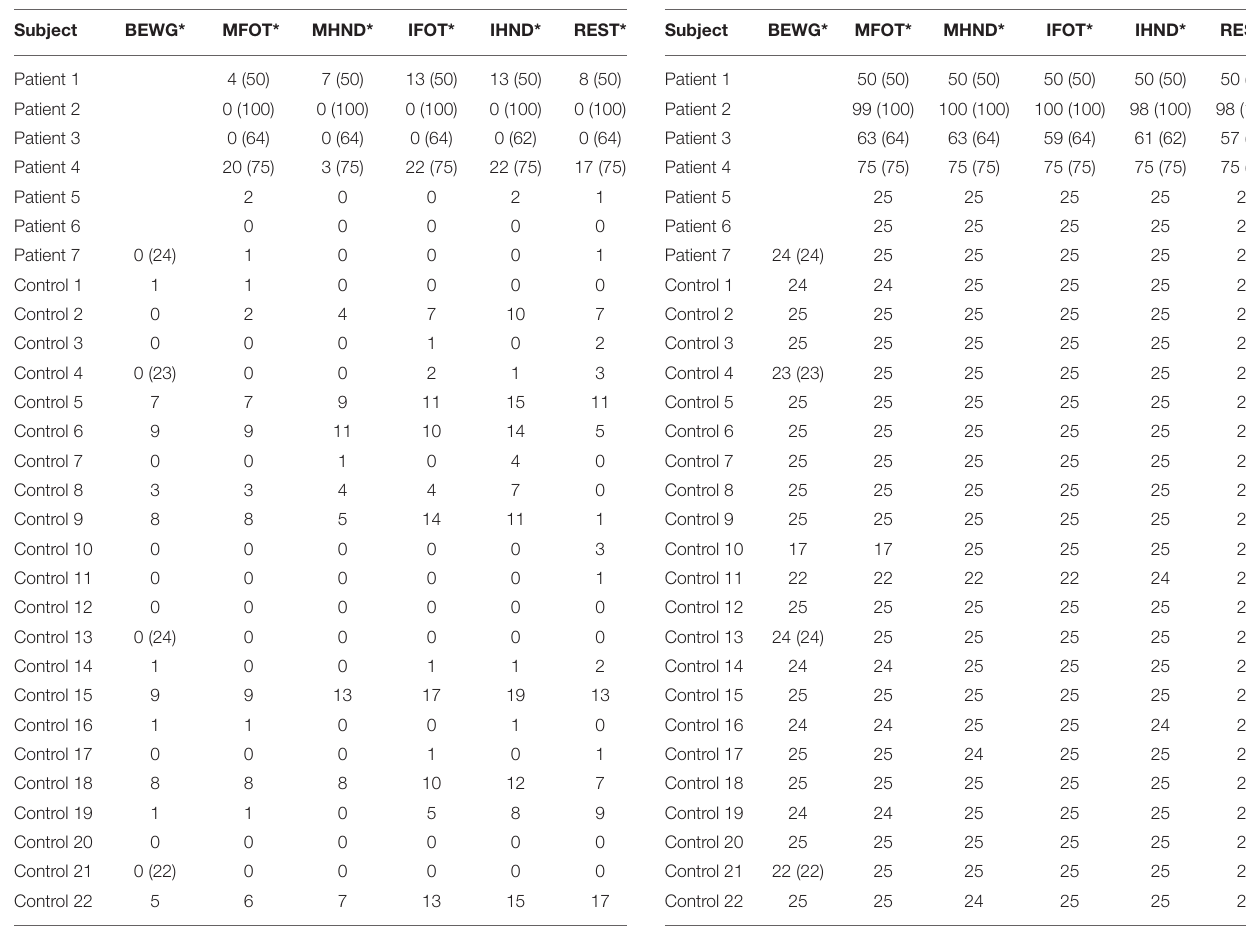
TABLE 3 | Number of included segments per condition after lenient artifact exclusion (number of recorded segments if not